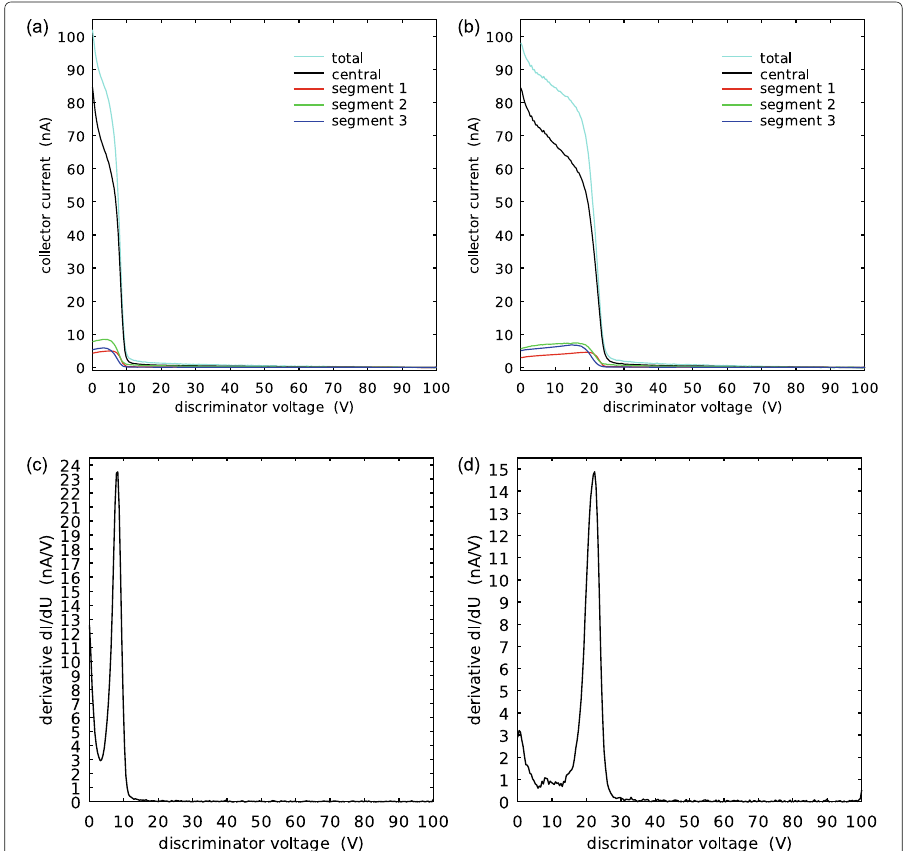
Fig. 7 RPA measurements at different plasma potentials in the HIBEX test chamber with the gridded ion source. The plasma potential is manipulated by means of the cathode (hot filament) bias voltage, (a) and (c) + 10V and (b) and (d) + 35V. The first row, (a) and (b), displays the raw RPA characteristics, and the second row, (c) and (d) the first derivative, representing the